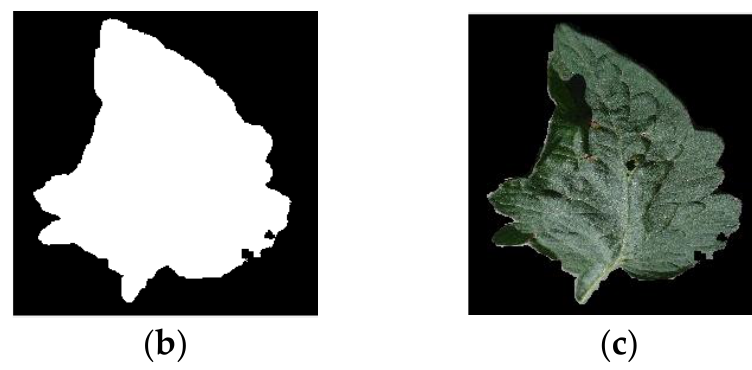
Figure 6. The results of the segmented image: ( a ) the RGB input image; ( b ) the binary image pro- cessed using one mask; ( c ) the image with the leaf region and the black background. Figure 7 shows the images after segmentation with the original leaf regions and the same black backgrounds, in which the leaves can retain the disease areas. Therefore, the dataset can speed up the training time, reduce many computations inside the neural net- work, and increase the accuracy.